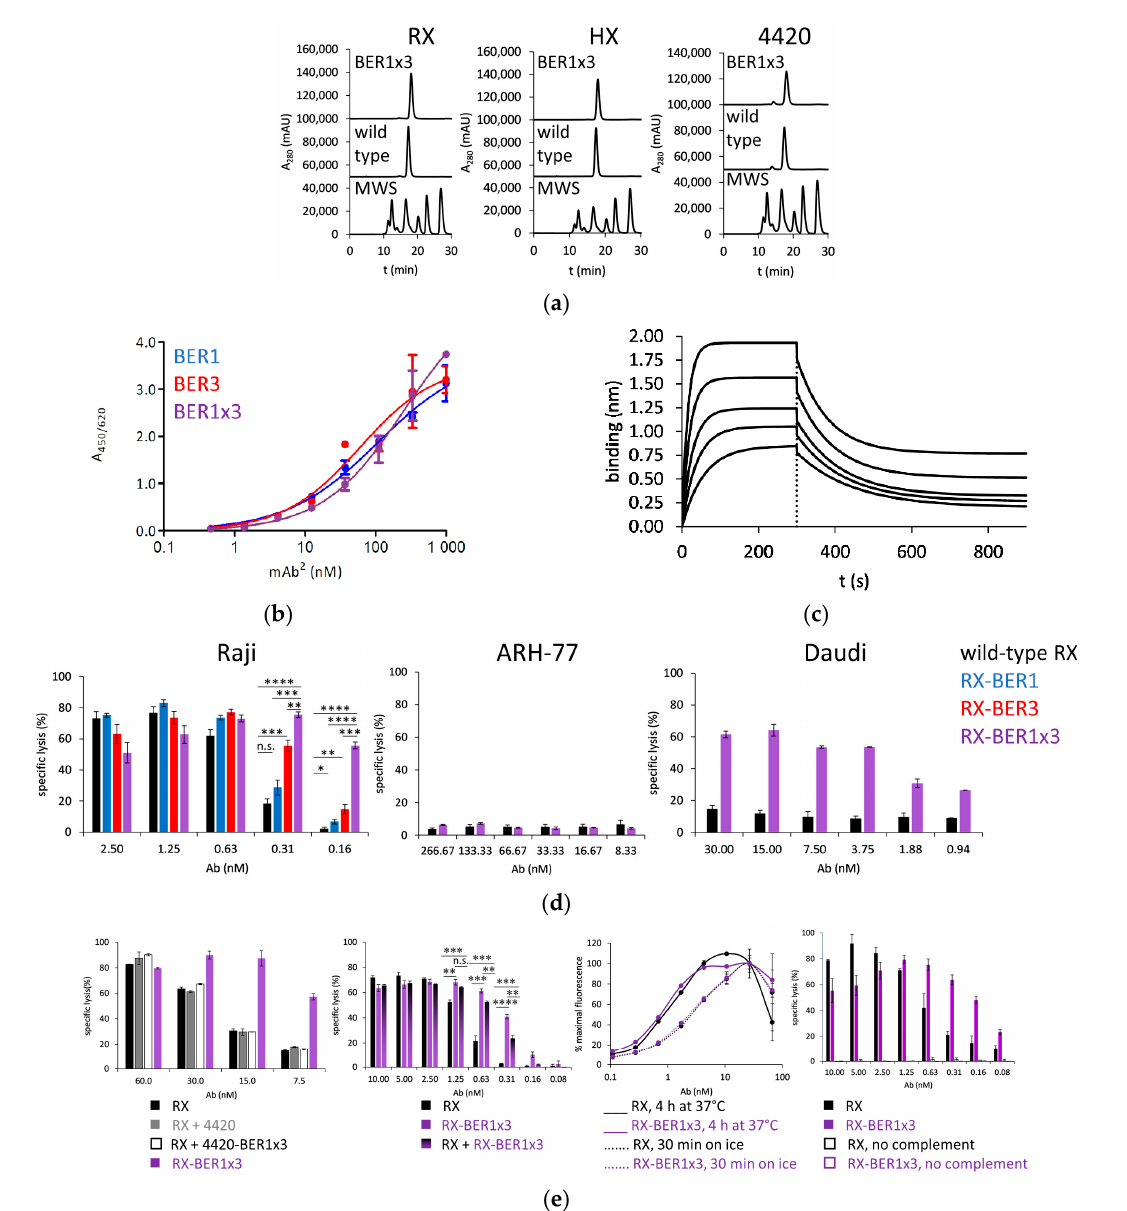
Figure 4. Characterization of shuffled BER1x3-clone based mAb 2 molecules: ( a ) SEC-HPLC profiles in native conditions of rituximab (RX)-, HuMax-20 (HX)- and 4420-based mAb 2 molecules (MWS: molecular weight standard); ( b ) ELISA response of RX-based bispecific antibodies with parental Fcabs and the shuffled clone to immobilized CD59; ( c ) Biolayer interferometry-determined binding of RX-BER1x3 to immobilized CD59, antibody in 2-fold dilutions starting with 300 nM; ( d ) Complement-dependent cytotoxicity (CDC) effect of RX-BER1, -3 and -1x3 for Raji and RX-BER1x3 for ARH-77 and Daudi cells. Sample size was n = 3 for Raji and n = 2 for ARH-77 and Daudi cells. One-way ANOVA was used to determine the significance (n.s. (not significant) 0.05 ≤ p , * 0.01 ≤ p < 0.05, ** 0.001 ≤ p < 0.01, *** 0.0001 ≤ p < 0.001, **** p ≤ 0.0001), mean and S.D. are presented; ( e ) 1st panel: CDC effect on Raji cells of RX, mix of RX and 4420 antibody, mix of RX and 4420-BER1x3 mAb 2 and RX-BER1x3 mAb 2 ( n = 2), 2nd panel: CDC effect on Raji cells of RX, RX-BER1x3, and mix of RX and RX-BER1x3 ( n = 3). One-way ANOVA was used to determine the significance (n.s. (not significant) 0.05 ≤ p , ** 0.001 ≤ p < 0.01, *** 0.0001 ≤ p < 0.001, **** p ≤ 0.0001), 3rd panel: Raji cell staining with RX and RX-BER1x3 at 4 °C and at 37 °C ( n = 2), 4th panel: the effect of RX and RX-BER1x3 on Raji cells with and without complement ( n = 2). Mean and S.D. are presented.